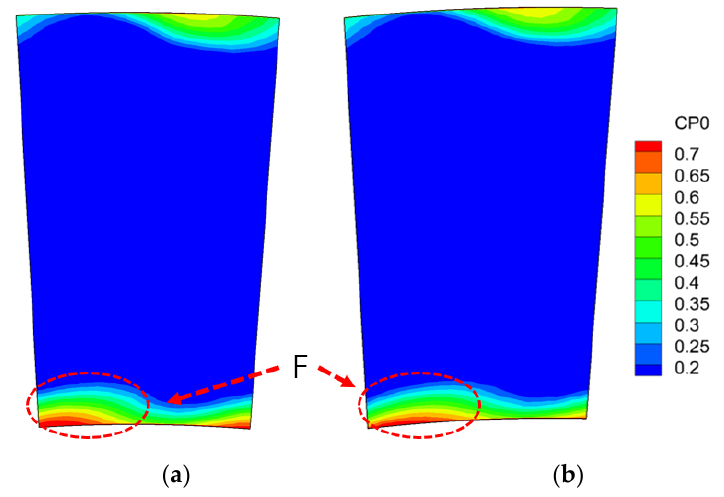
Figure 13. Stagnation pressure coefficient on the vane exit. ( a ) Convex ( b ) Restacked.